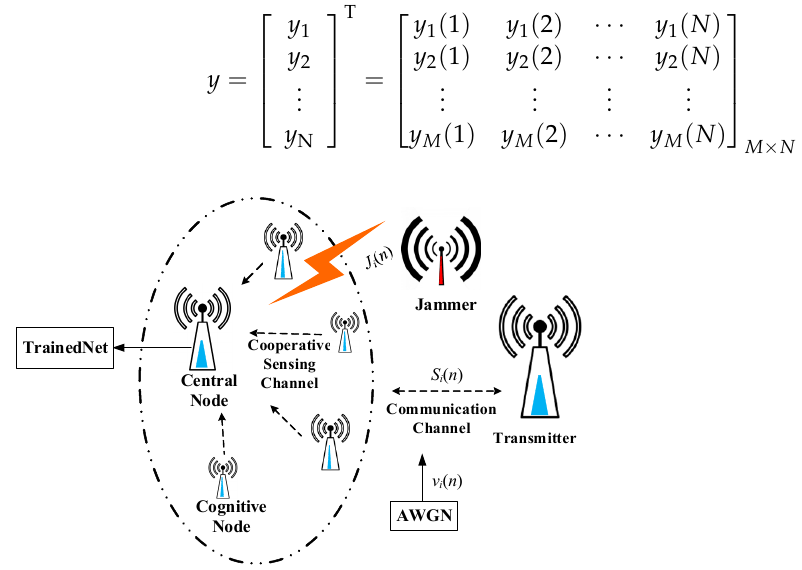
Figure 1. Framework of multi-node cooperative jamming recognition.